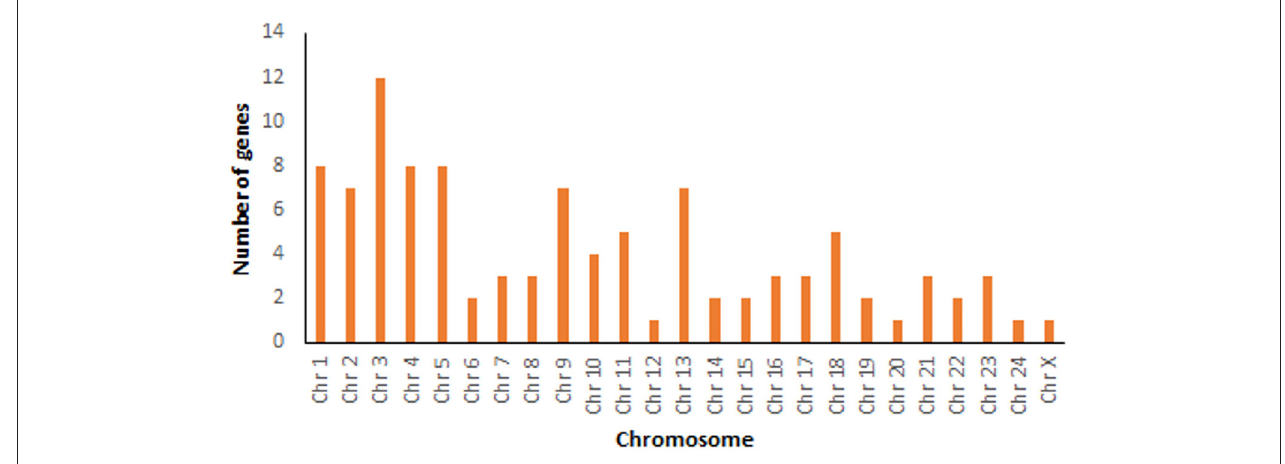
FIGURE 2 | Chromosome-wise mapping of 101 mastitis associated genes in Bubalus bubalis .